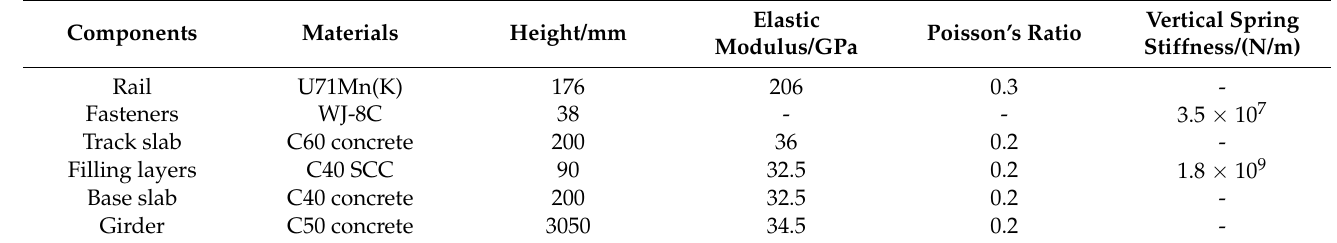
Table 1. The materials and properties of the bridge and CRTS III SBT system.